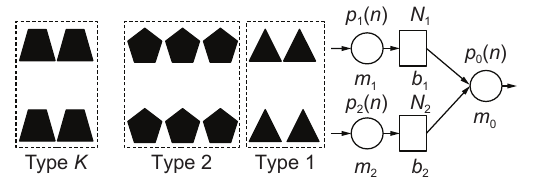
Fig. 2 Batch-based assembly system with three Bernoulli machines. Table 1 Arrangement of system states.